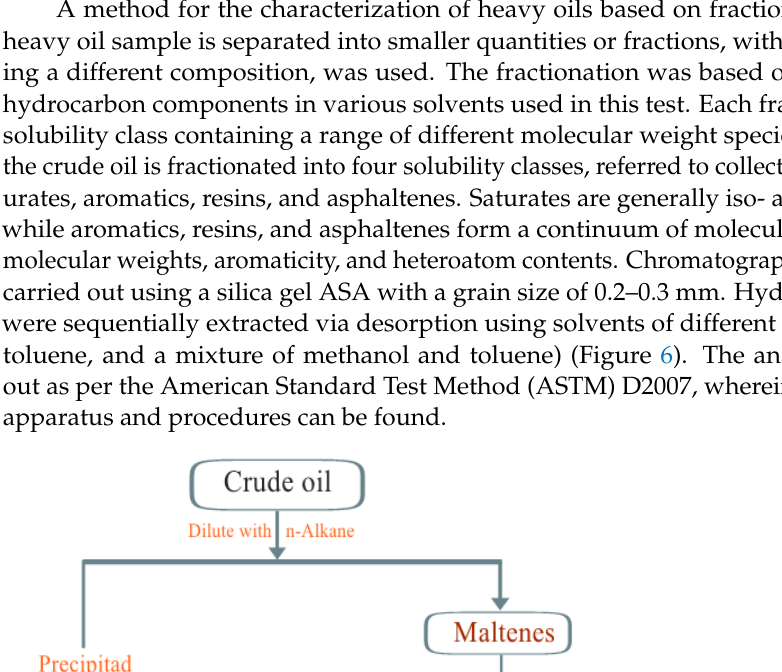
Figure 5. Laboratory autoclave with catalytic reactor.